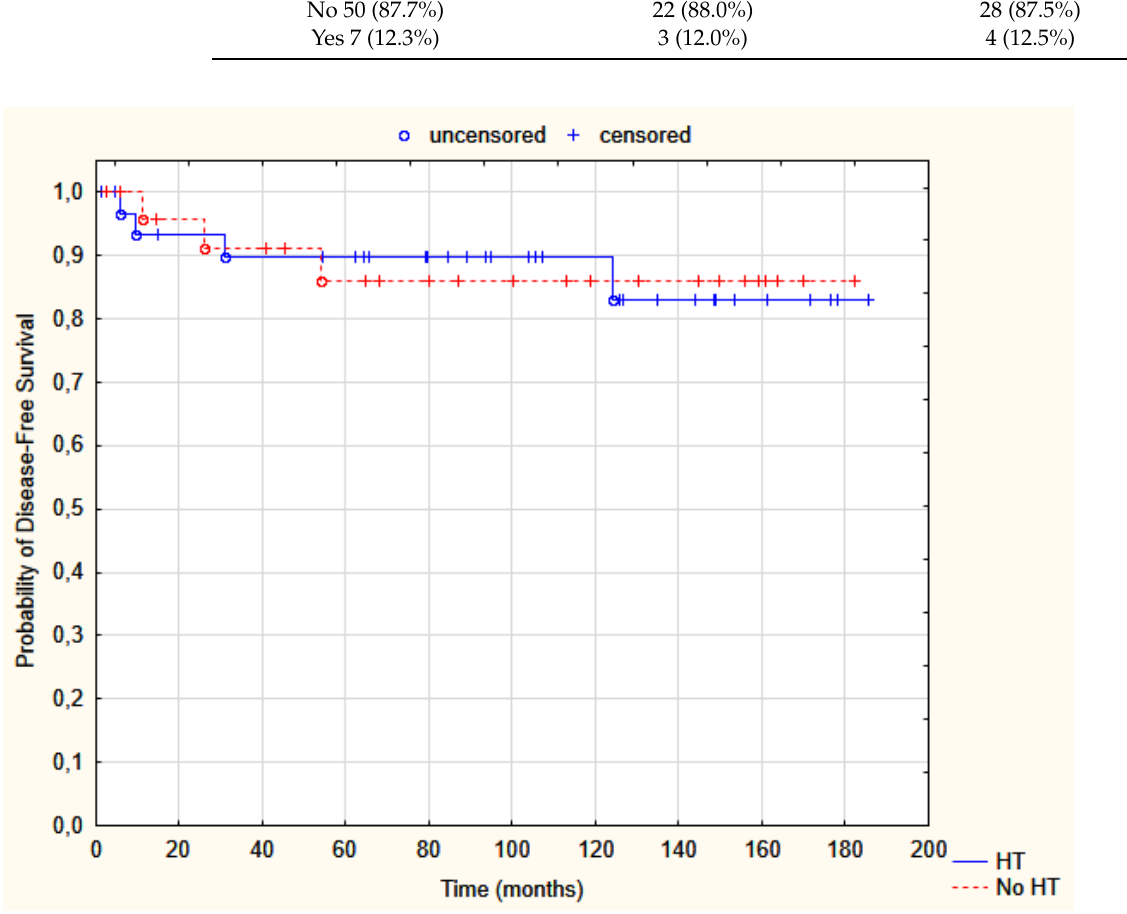
Figure 1. Probability of local control in group A, HDR-BT (red dotted line), and B, HDR-BT + thermal boost (blue solid line); Test log-rank, p = 0.59. HT—hyperthermia. The 5-year and 10-year DFS was 88.3% and 88.3%, respectively. Overall, 7 out of 57 patients (12.3%) developed distant metastases (3 cases in group A, 4 in B) (Table 2). Of them, only one patient is still alive. DM and LR did not co-occur. Combined, DFS proba- bility is displayed in Figure 2.